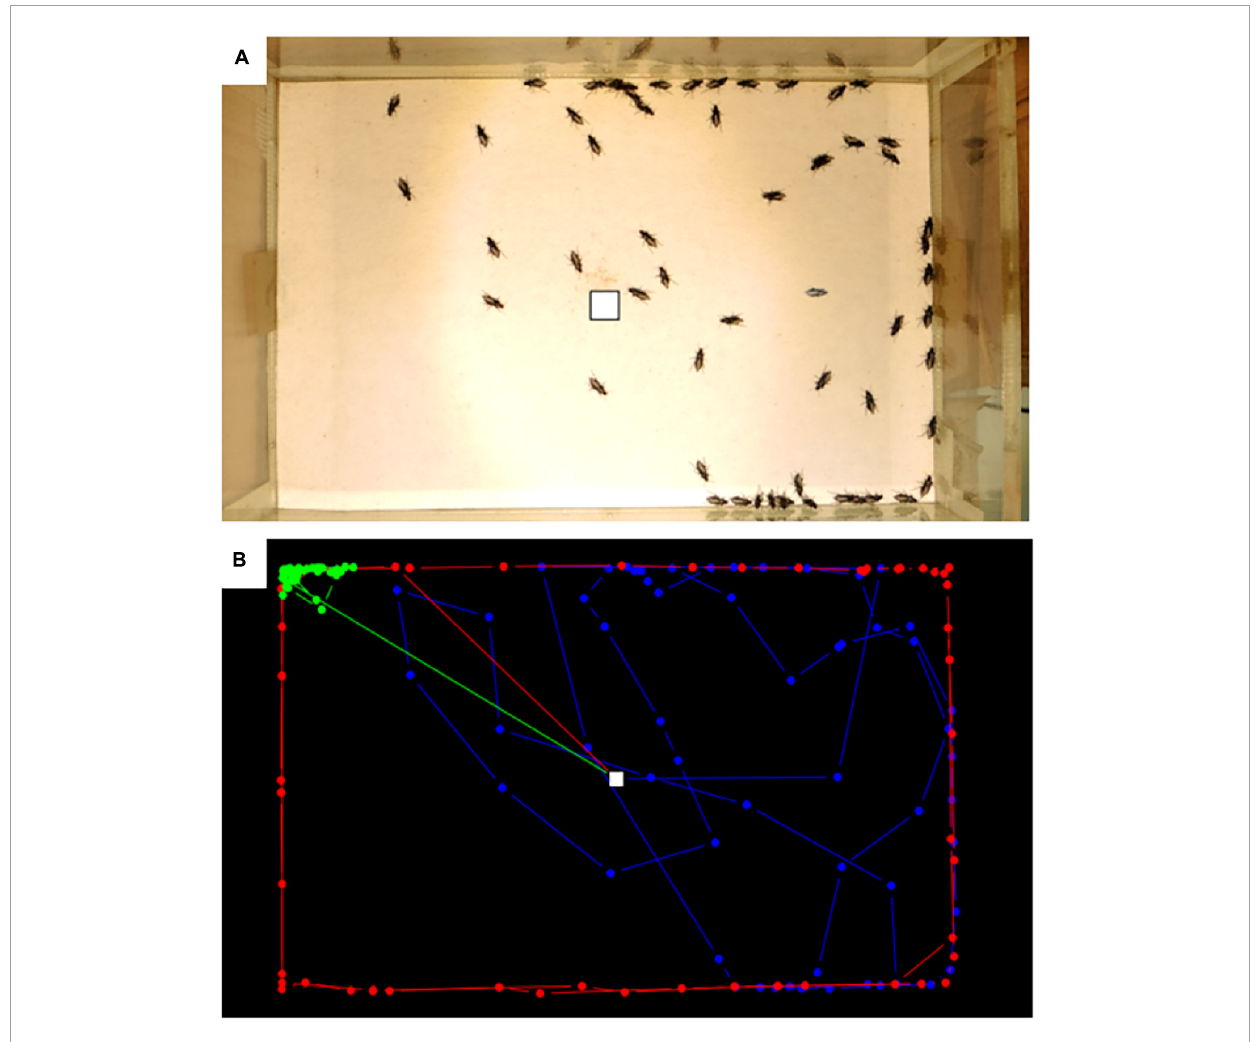
FIGURE2 Monitoring beetle movements in the lab, (A) example of an experimental run with all-time steps overlapped, (B) example of three contrasting trajectories in blue, green and red. White square correspond to the release